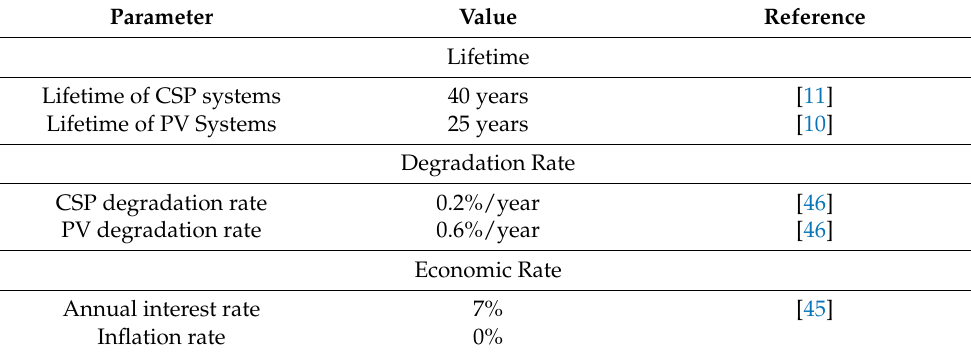
Table 8. Technical parameters for the economic evaluation of the hybrid plant.